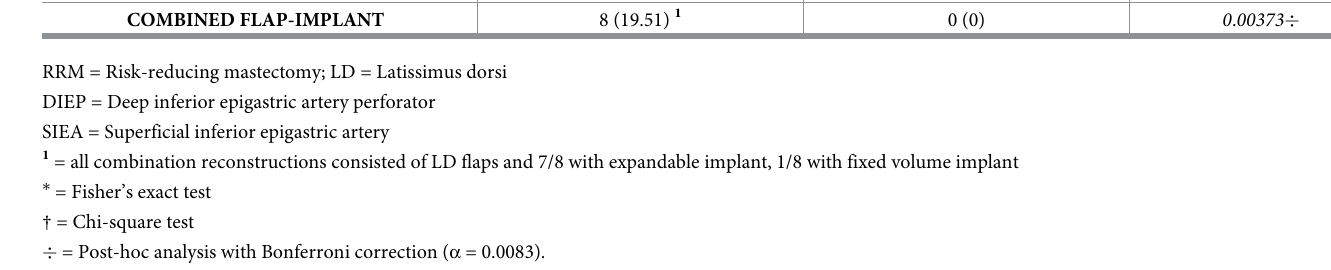
RRM = Risk-reducing mastectomy; LD = Latissimus